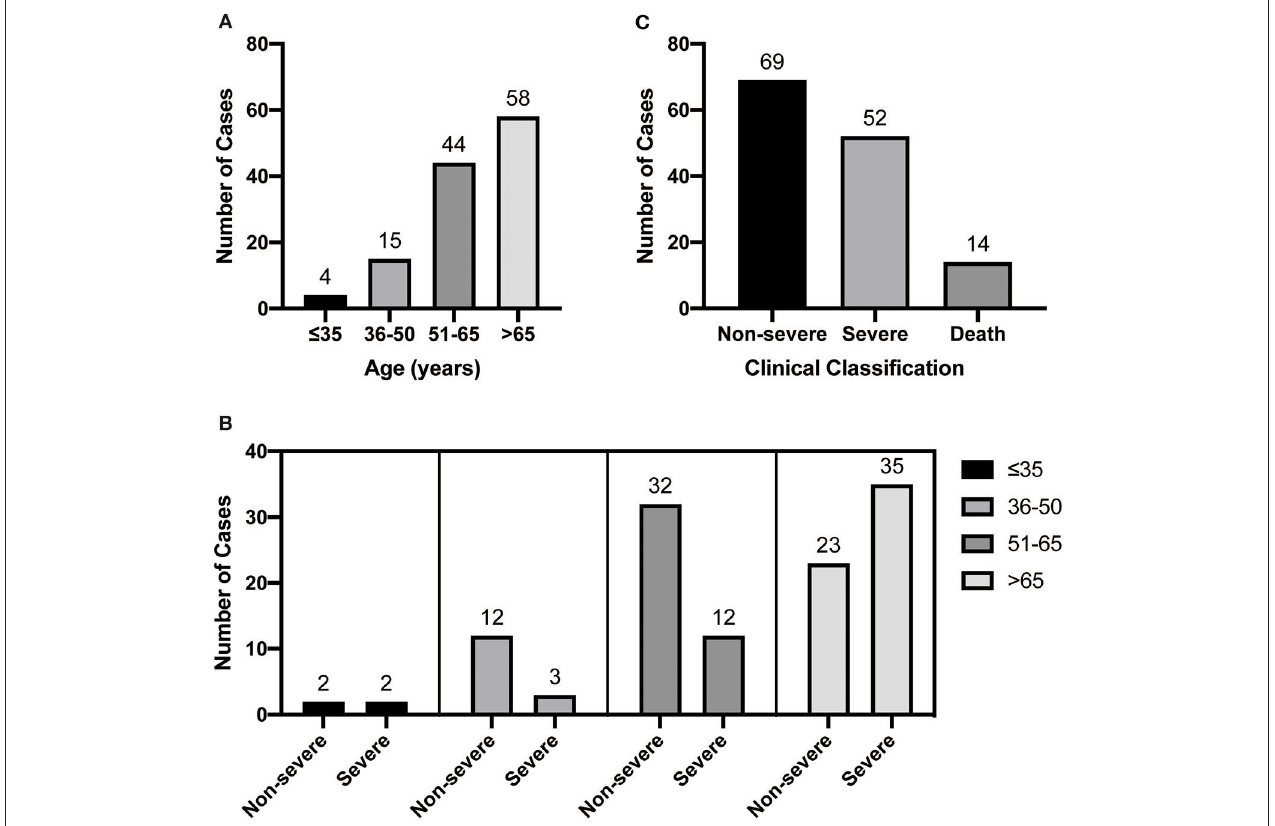
FIGURE 1 | Patient age distribution (A) , clinical classification (B) , and age distribution of severe and non-serious patients (C) .